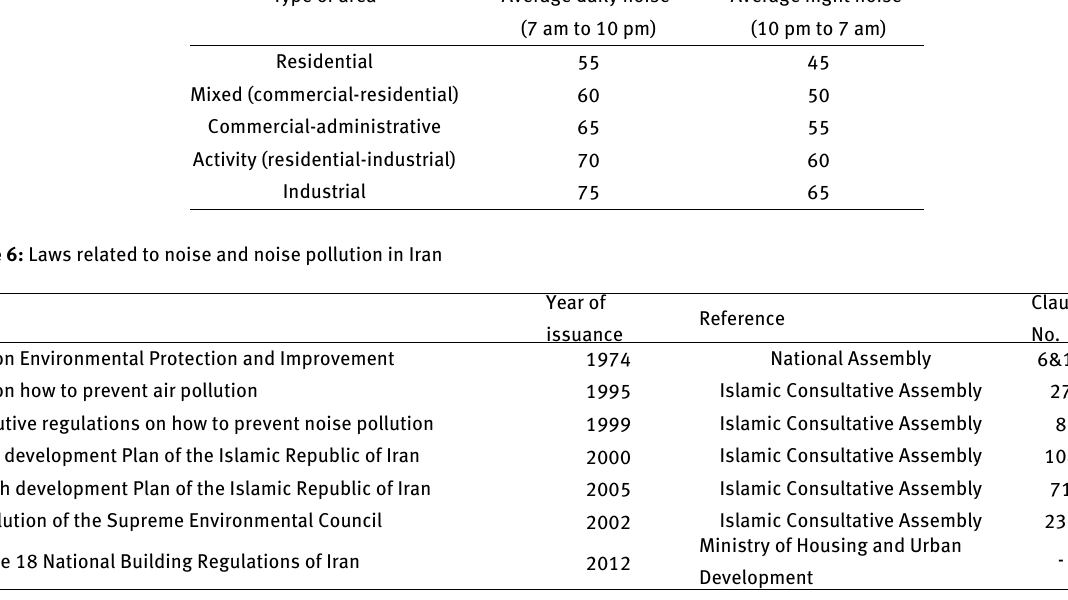
Table 5: Permissible limit of noise in different types of buildings [54]. Type of area Average daily noise (7 am to 10 pm) Mixed (commercial-residential)